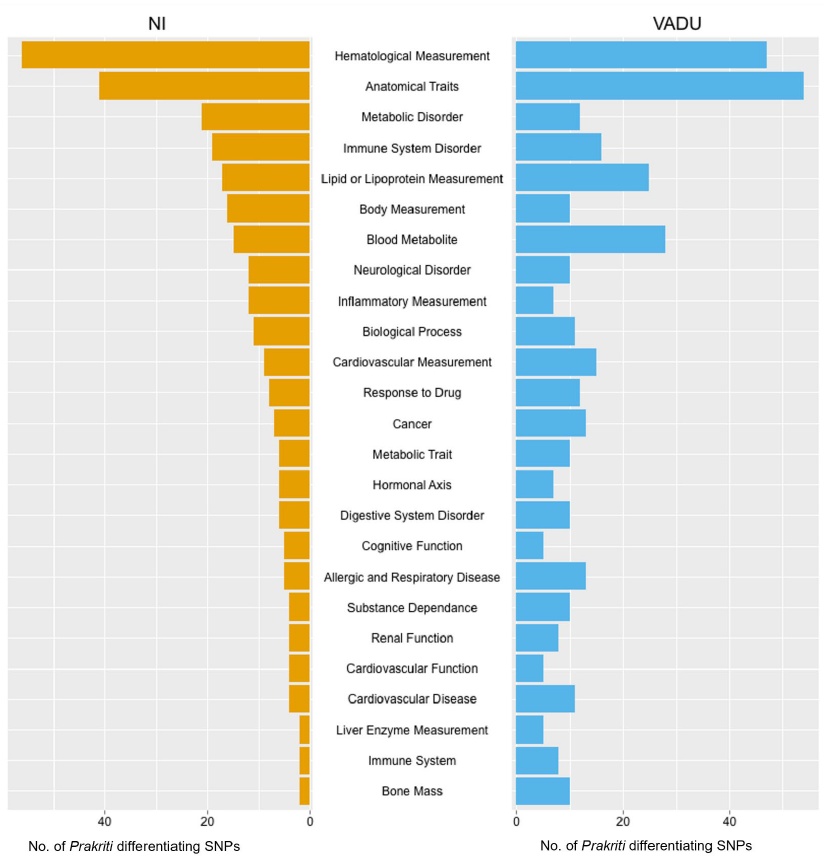
Figure 1. Barplot showing number of Prakriti differentiating SNPs associated with top 25 GWAS disease/traits Parent terms in NI and Vadu cohort. 3.4. Enriched Disease/Traits Associated with Prakriti Differentiating Genetic Variations Enable Risk Stratification